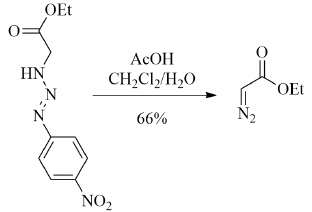
Figure 41 - Acid catalyzed fragmentation of an aryl triazene derivative for the formation of ethyl diazoacetate.